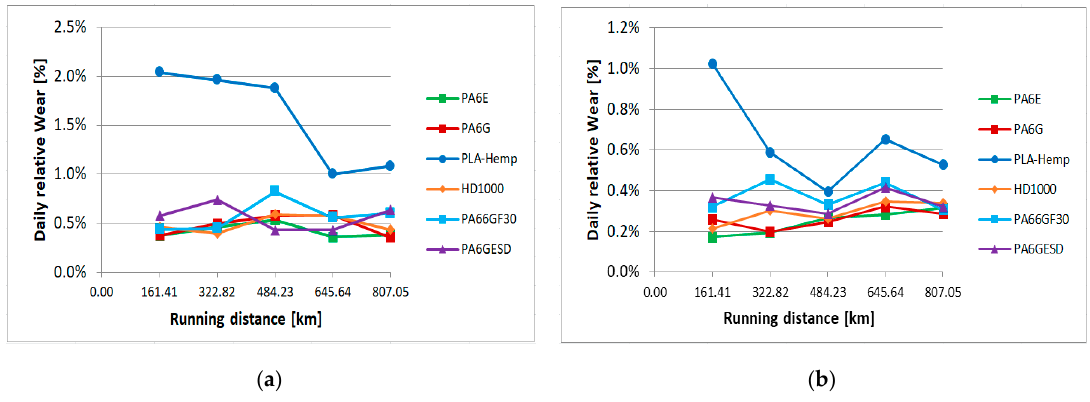
Figure 13. Daily relative wear in position 1 (Figure 3) with skeletal ( a ) and loamy ( b ) soil-based